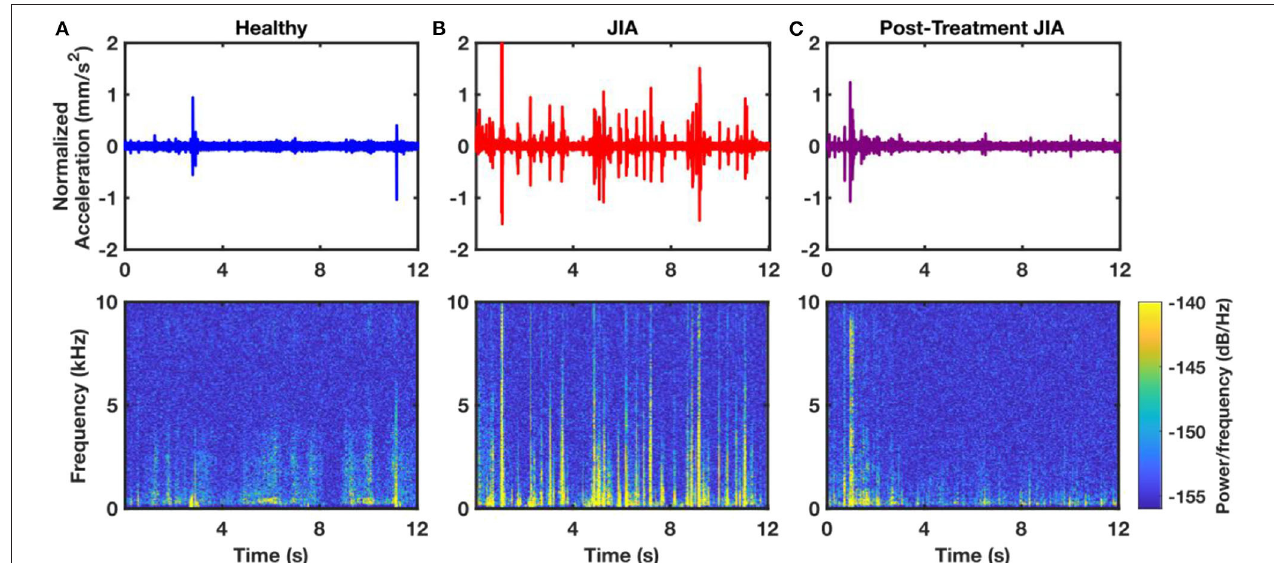
FIGURE 2 | Representative time-domain and spectrogram plots of JAEs from a sample healthy control (A) , a subject with active JIA (B) , and that same subject after 6-weeks of successful treatment (C) . The 12s of the JAEs represent approximately 4 flexion/extension cycles. Spectrogram of the subject with JIA contains more high power and high frequency components compared to that of healthy and post-treatment